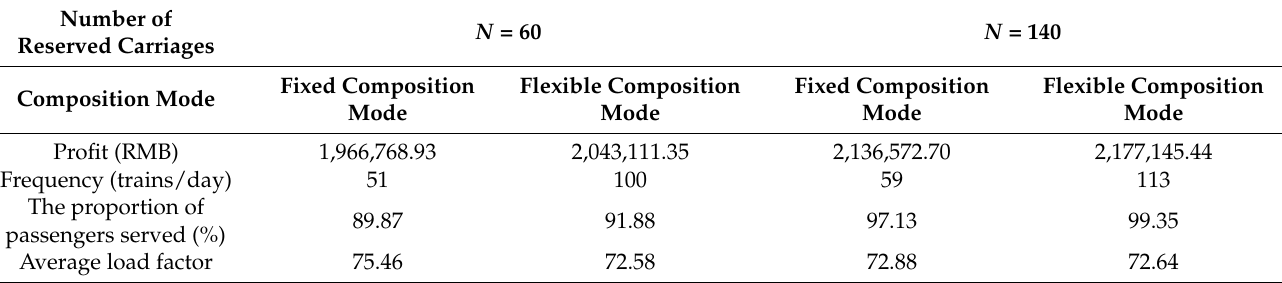
Table 5. Indicators of the line